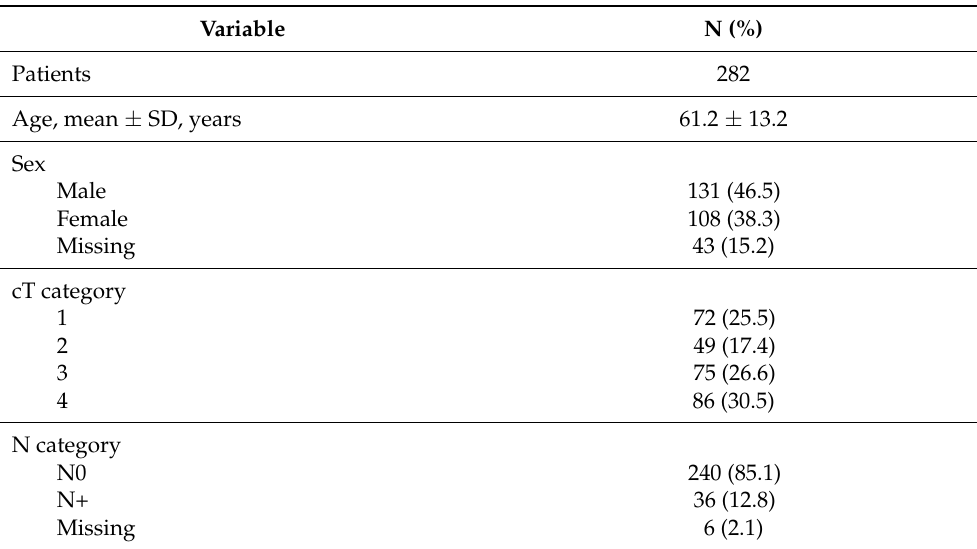
Table 2. Pooled data of patients with external auditory canal squamous cell